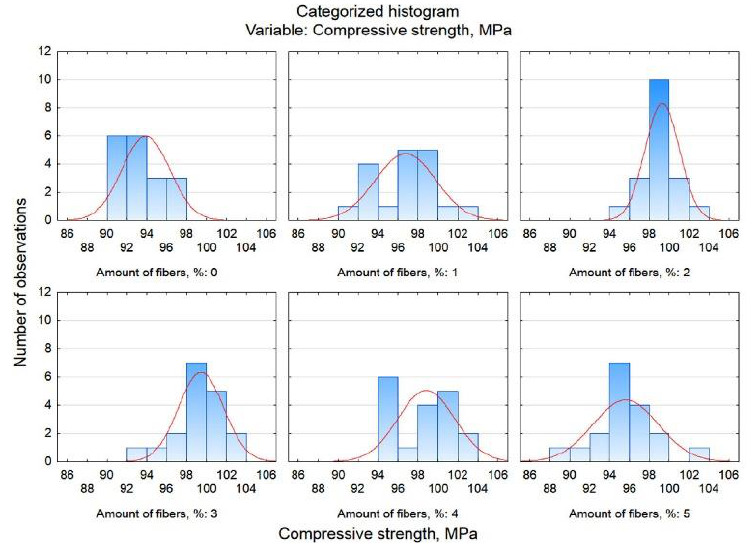
Figure 13. Categorized histograms of compressive strength related to fibre content.